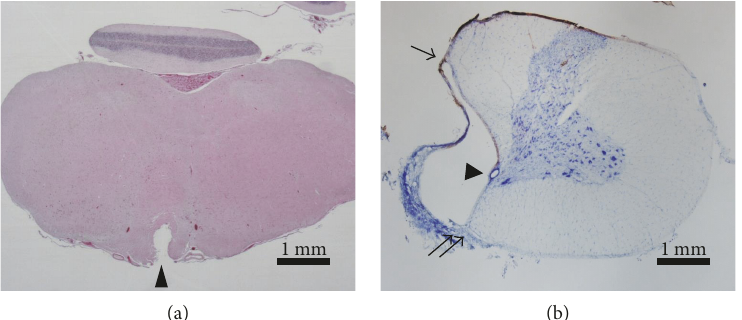
Figure 4: Pathological image of the stimulated part of the pyramid and the hemisected part of the cervical cord. (a) Microscopic image of the stimulated part of the pyramid having undergone burnout process (midbrain level); arrow head: pyramid. (b) Microscopic image of the hemisected part of the cervical cord (C5 segment level) (modi fi cation from document 3); arrow head: central canal; arrows: anterior median fi ssure; arrow: dorsal median